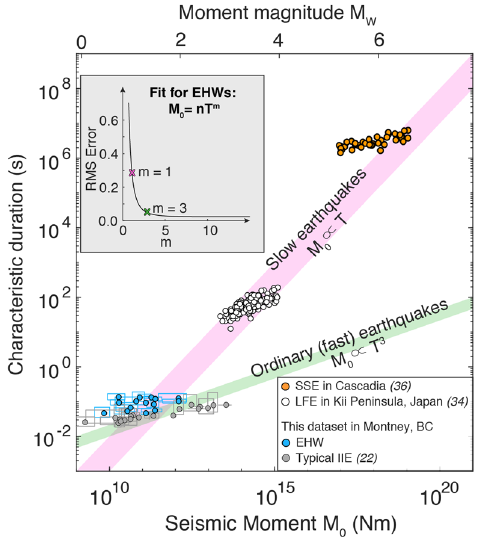
Fig. 3 Source parameter estimates of the broadband onset. Pink/green shaded bar: proposed moment-duration scaling for slow and typical (fast) earthquakes 36 . Blue/gray dots with rectangles: EHWs/typical injection- induced events in this study. Horizontal uncertainty: estimated from the standard error of low-frequency amplitude variance. Vertical uncertainty: reciprocal of frequency band with 5% increase of fi t variance. White dots: low-frequency earthquakes in Kii Peninsula, Japan; 37 orange dots: slow-slip events in Cascadia 39 . Inset: fi t for moment-duration scaling of EHWs assuming M 0 = n T m . The RMS error decreases 86% when the exponent of T increases from m = 1 (pink cross) to m = 3 (green cross),